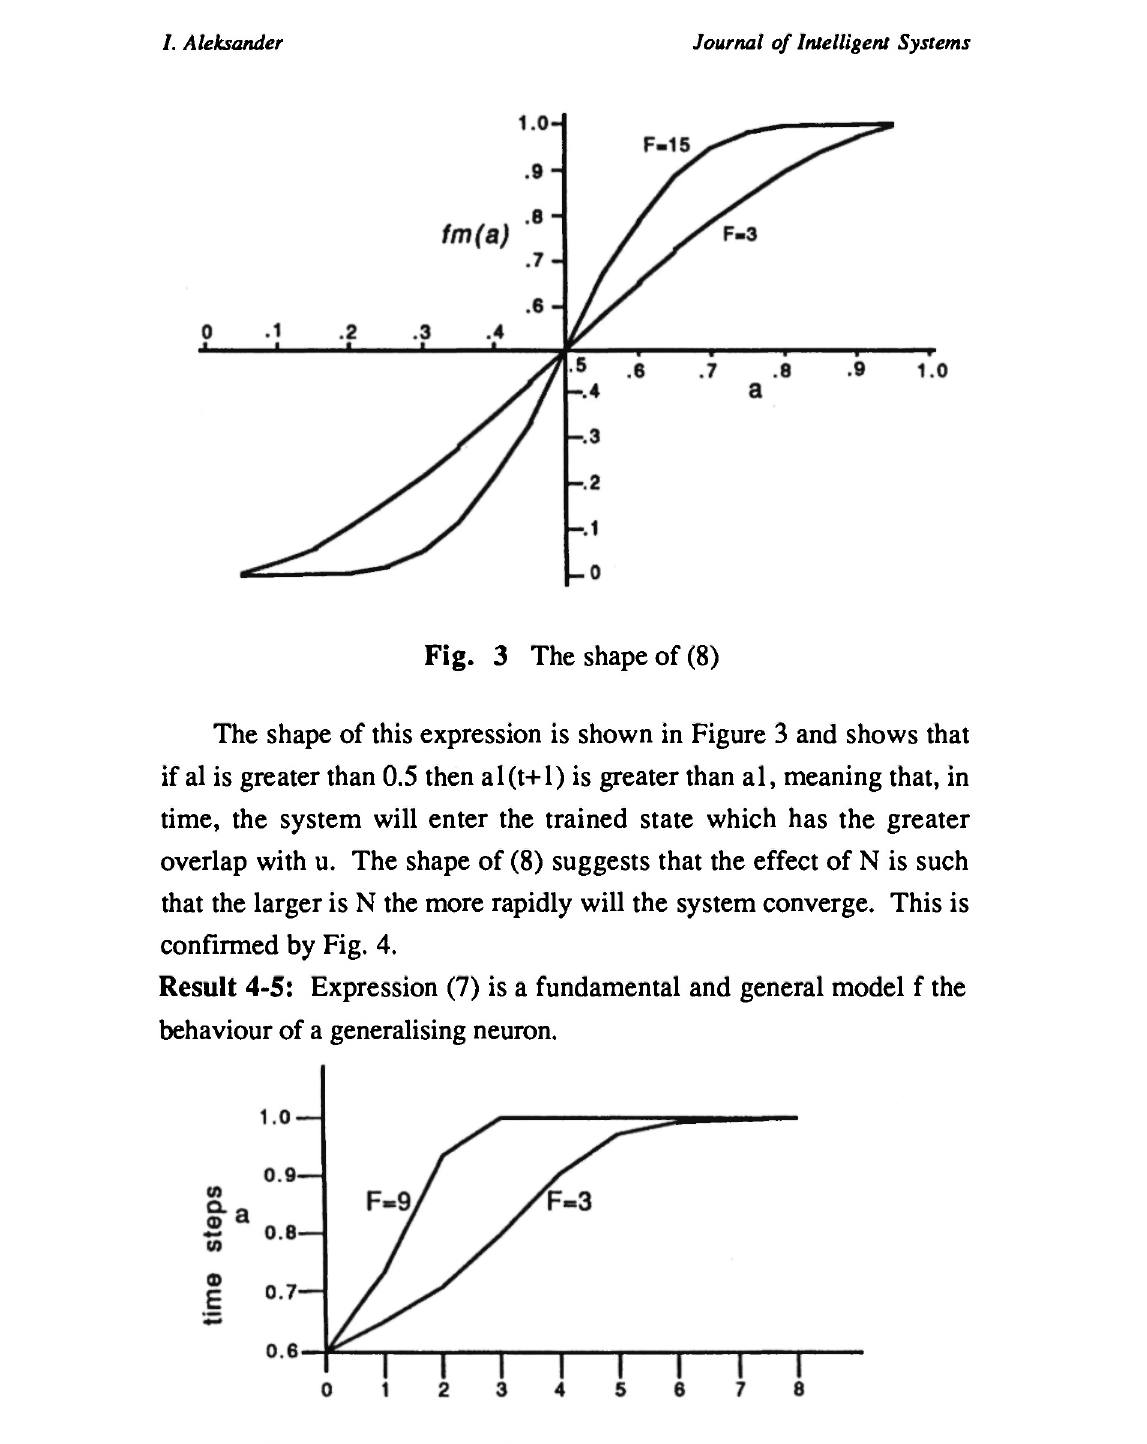
Fig. 4 The effect of Ν on retrieval speed for a =